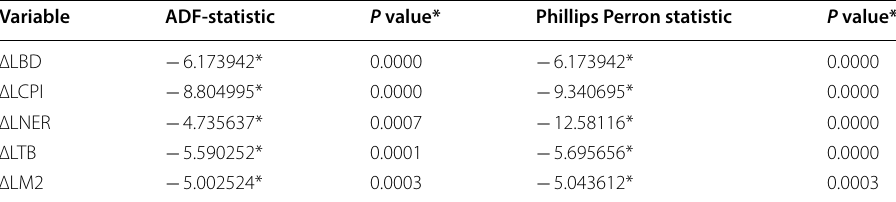
Table 3 Unit root test results at first difference